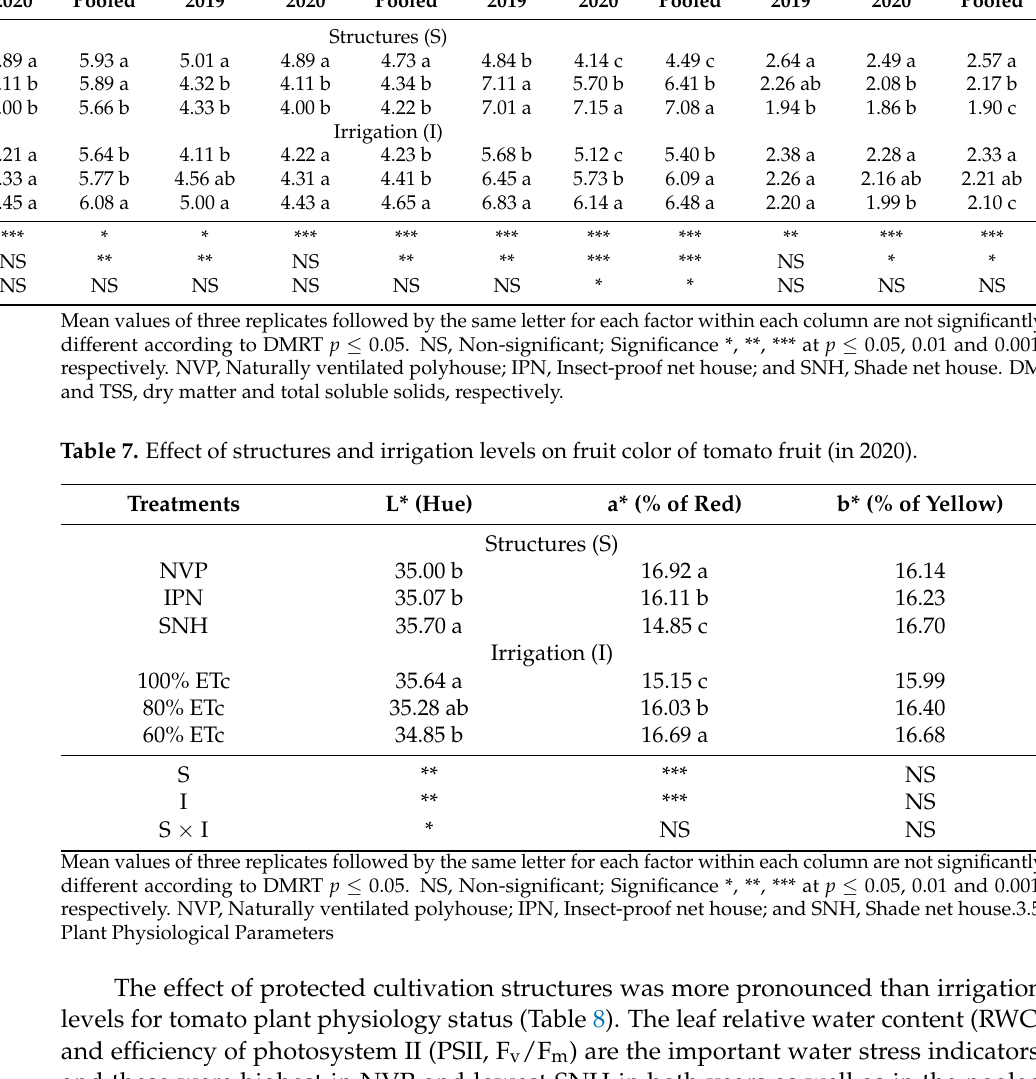
Table 6. Effect of structures and irrigation levels on fruit quality parameters of tomato. Treatments